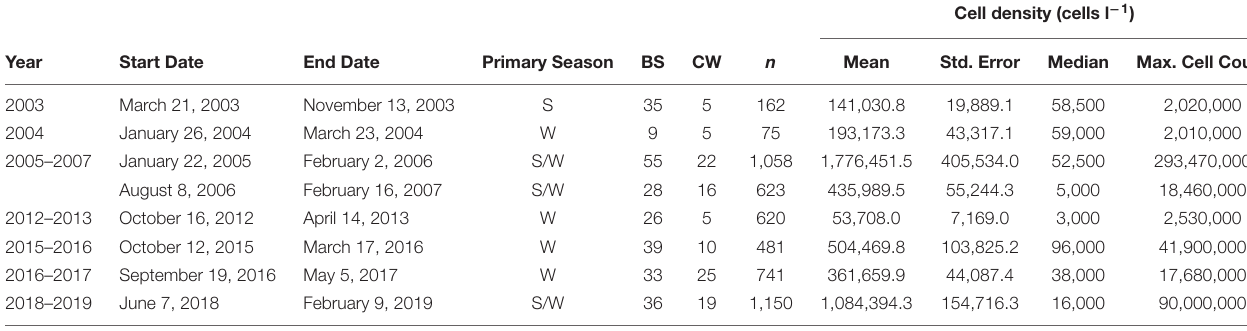
TABLE 3 | Duration and intensity of red tide blooms affecting the Sarasota Bay study area during 2003–2019.